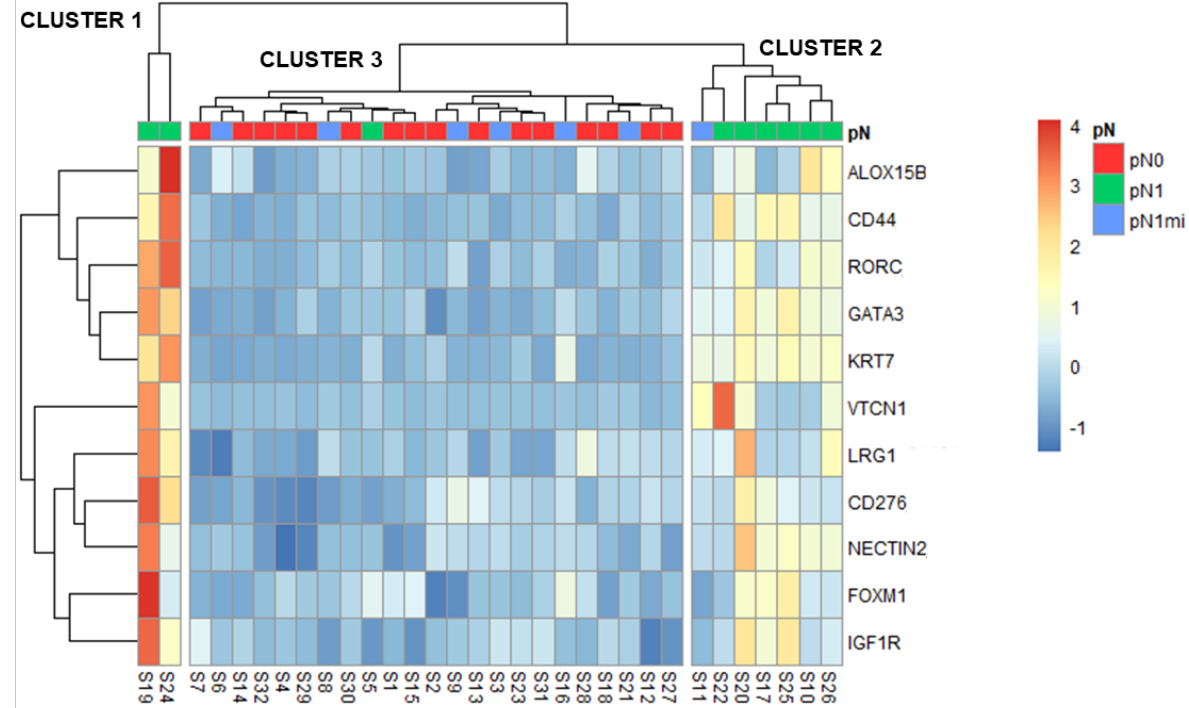
Figure 5. Heatmap and hierarchical clustering with the 11 DEGs (identified when comparing pN1 with pN0). Z-scores are represented by the color scale. Clusters are shown separated.